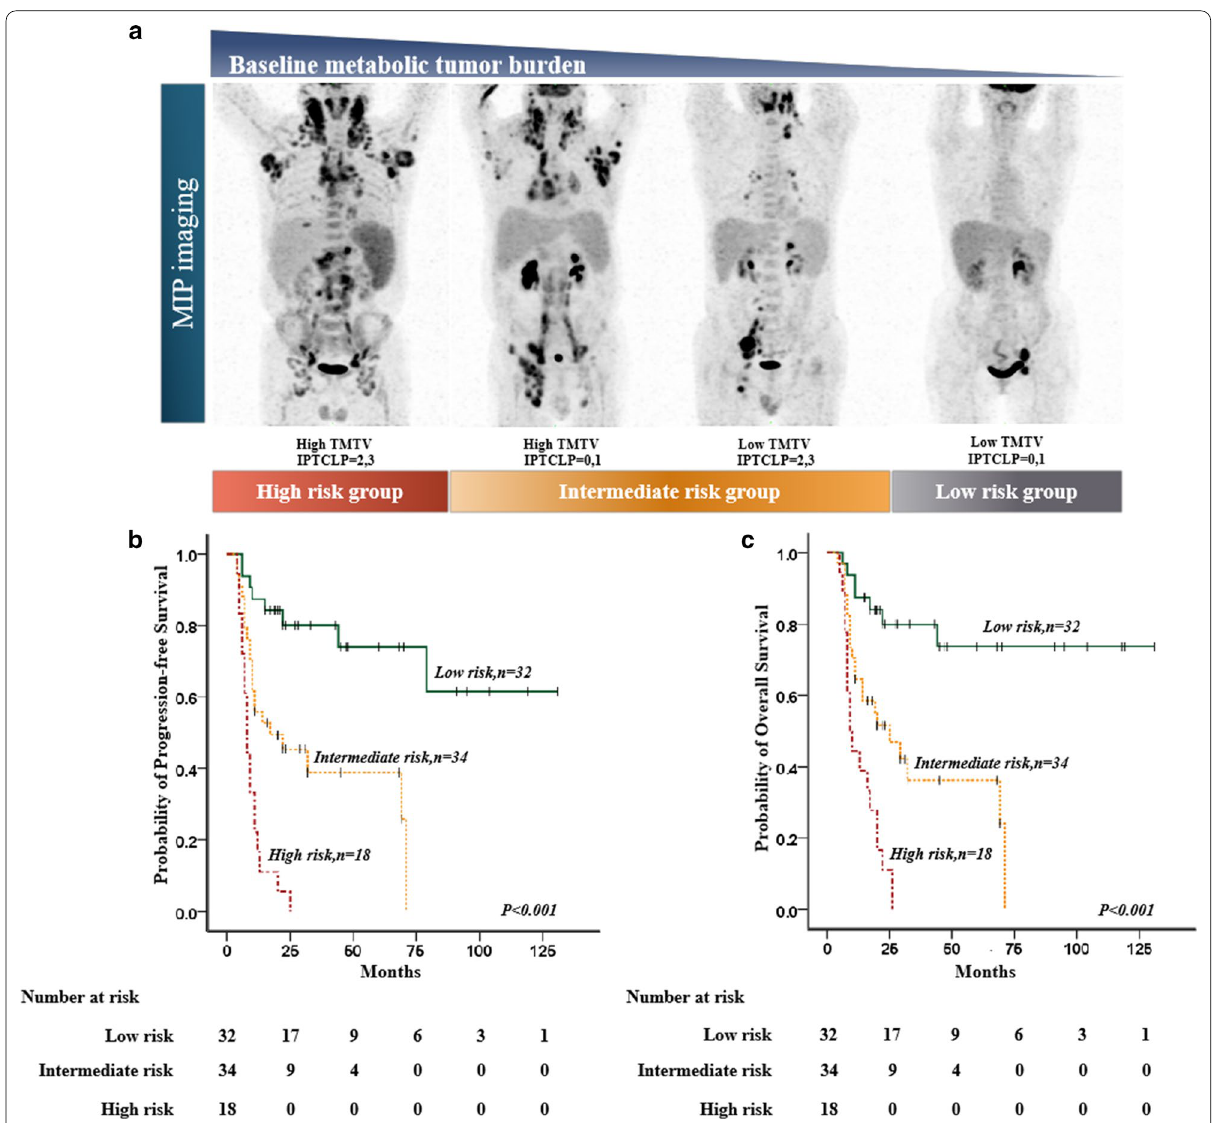
Fig. 2 a Illustration of combination of total metabolic tumor volume and IPTCLP scores for risk substratification of PTCL patients using maximal intensity projection on FDG-PET images. b , c Three risk groups with the combination of baseline TMTV and IPTCLP scores: low-risk group (IPTCLP 0, 1 and low TMTV, n 32), intermediate-risk group (IPTCLP = = n 18) =